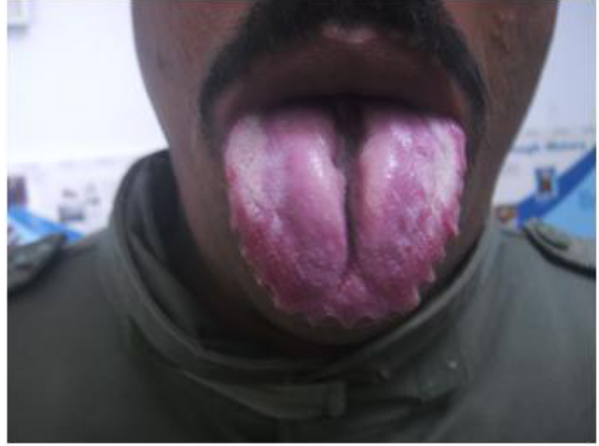
Figure 2: Teeth marks on tongue edges (scalloped tongue).